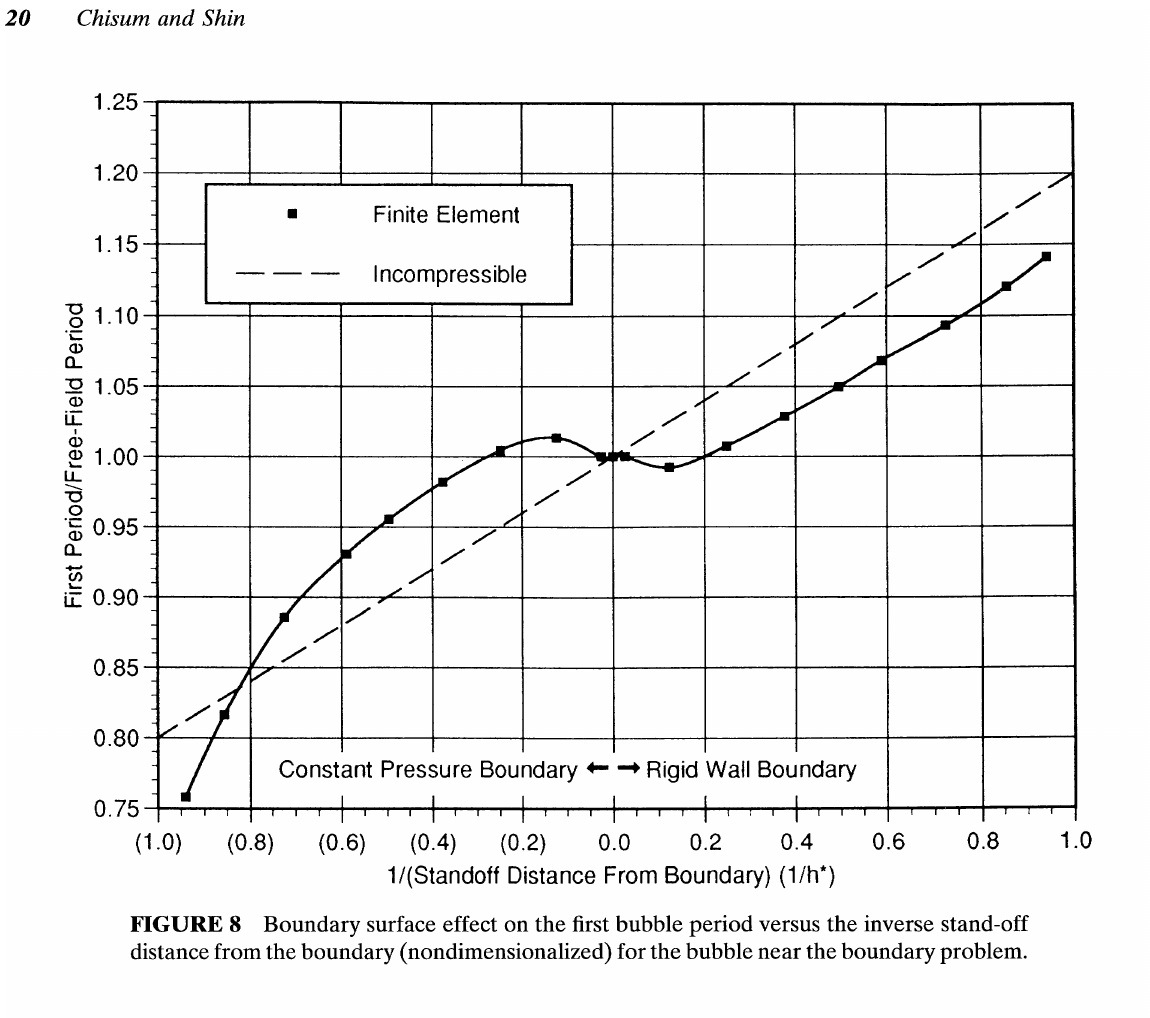
FIGURE 8 Boundary surface effect on the first bubble period versus the inverse stand-off distance from the boundary (nondimensionalized) for the bubble near the boundary